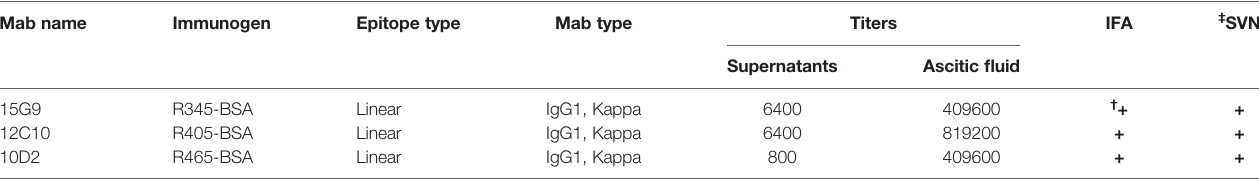
TABLE 2 | Characteristics of mAbs.